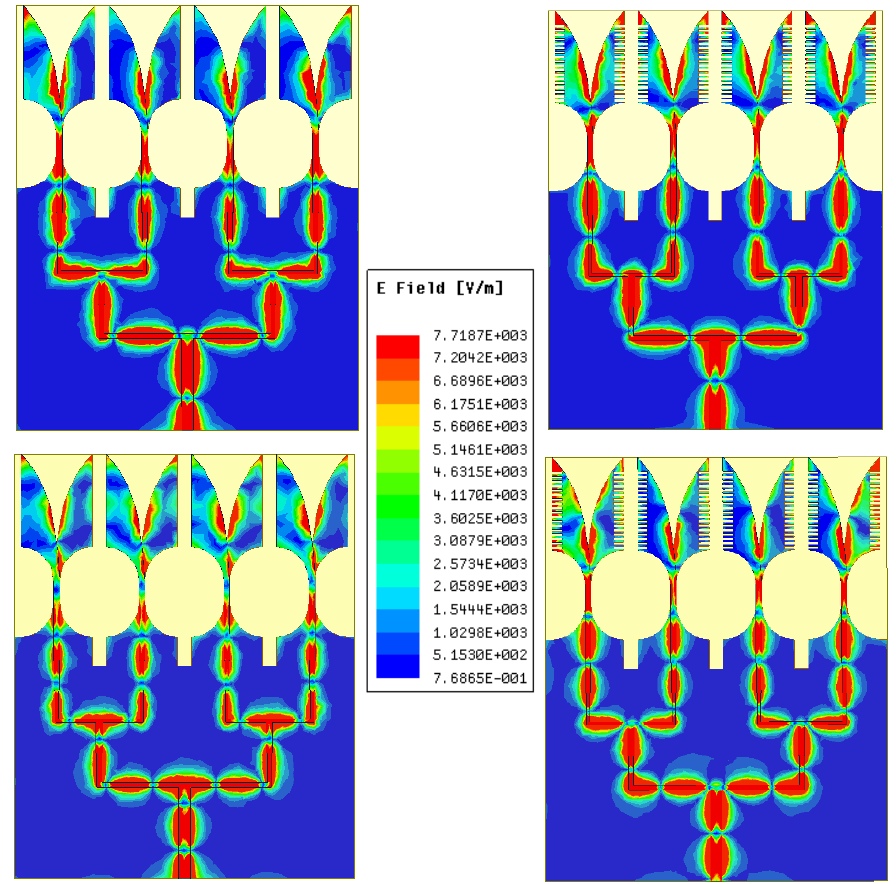
Figure 16. Electric field distribution of the AVA array with and without corrugations at 25 GHz ( upper ) and 34 GHz ( lower